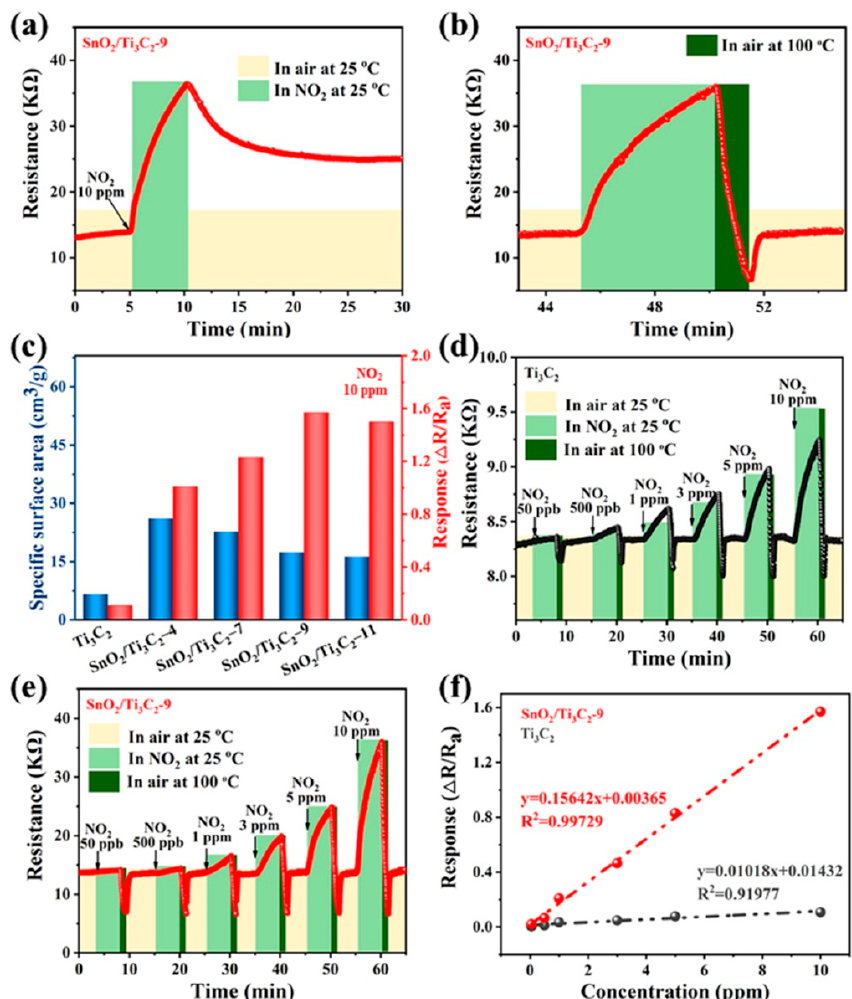
Figure 16. Response/recovery curves of SnO 2 /Ti 3 C 2 -9%HCL composite at RT ( a ) before and ( b ) after the pulse-heating treatment; ( c ) specific surface area and responses of pristine Ti 3 C 2 and SnO 2 /Ti 3 C 2 composites to 10 ppm NO 2 ; ( d , e ) response/recovery curves; and ( f ) linear fitting curves of pristine Ti 3 C 2 and SnO 2 /Ti 3 C 2 -9 composite to 0.5–10 ppm NO 2 . Reprinted with permission from [120]. Copyright 2022: Elsevier B.V.